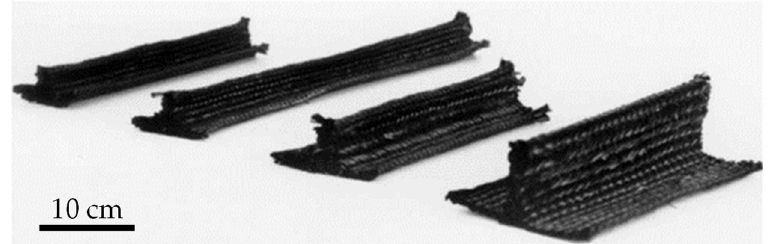
Figure 10. Various 3D braided T-profile-shaped geometries.